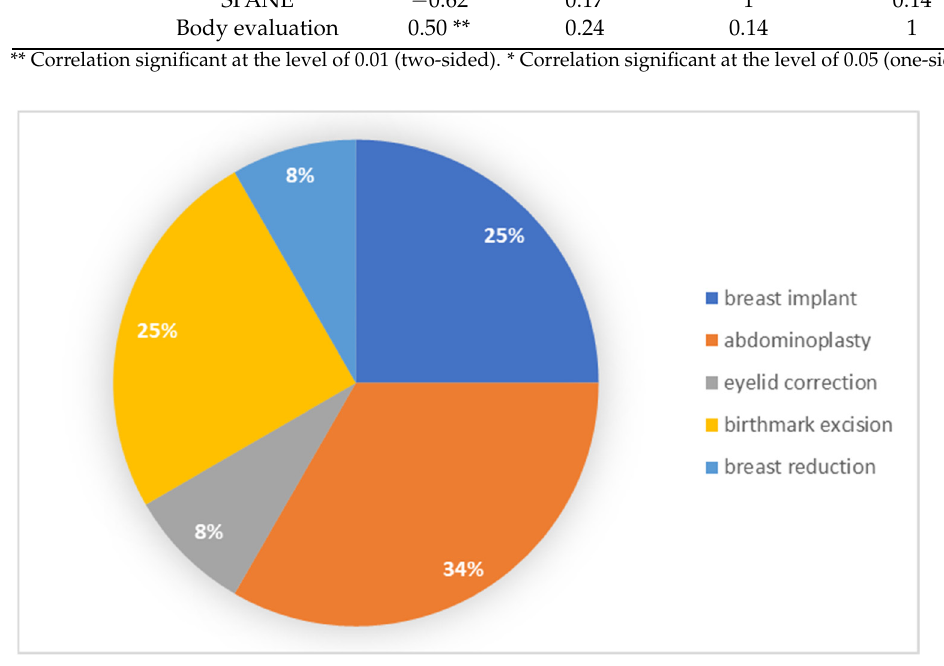
** Correlation significant at the level of 0.01 (two-sided). * Correlation significant at the level of 0.05 (one-sided).